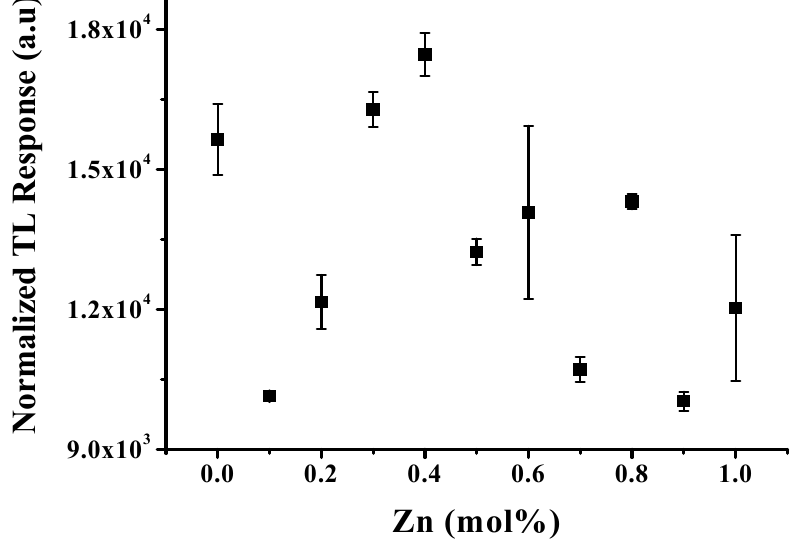
Figure 6. Glow curves of MgB 4 O 7 :Zn glass with different dopant concentrations.